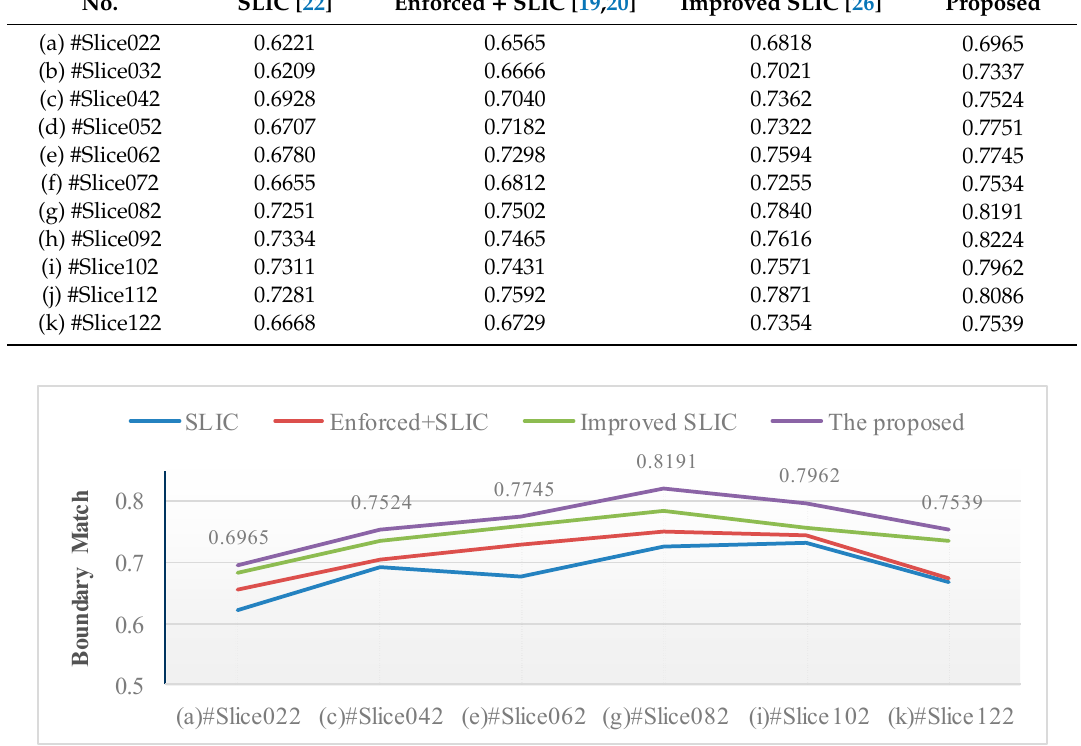
Figure 7. The boundary match of different algorithms on selected slices.